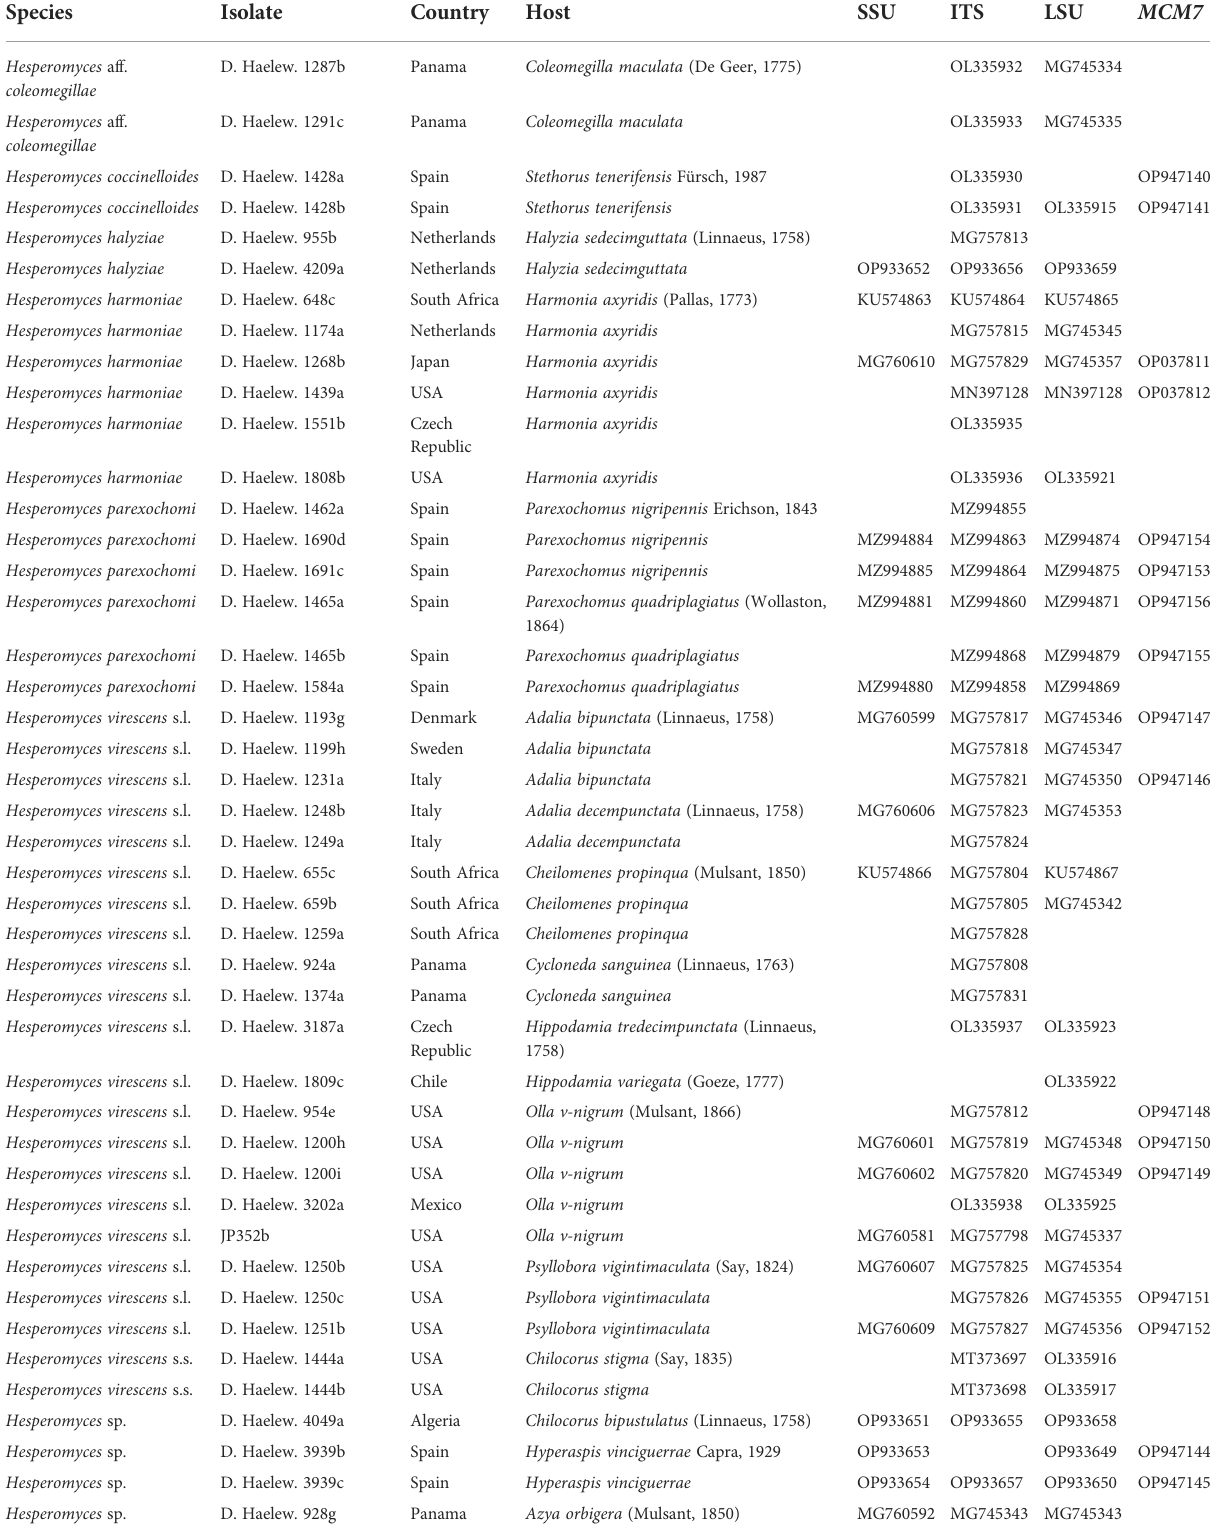
TABLE 1 Details of all the isolates used in the study, including species name, country of collection, host species, and the GenBank accession numbers of the small subunit (SSU), internal transcribed spacer (ITS), large subunit (LSU), and minichromosome maintenance complex component 7 ( MCM7 )